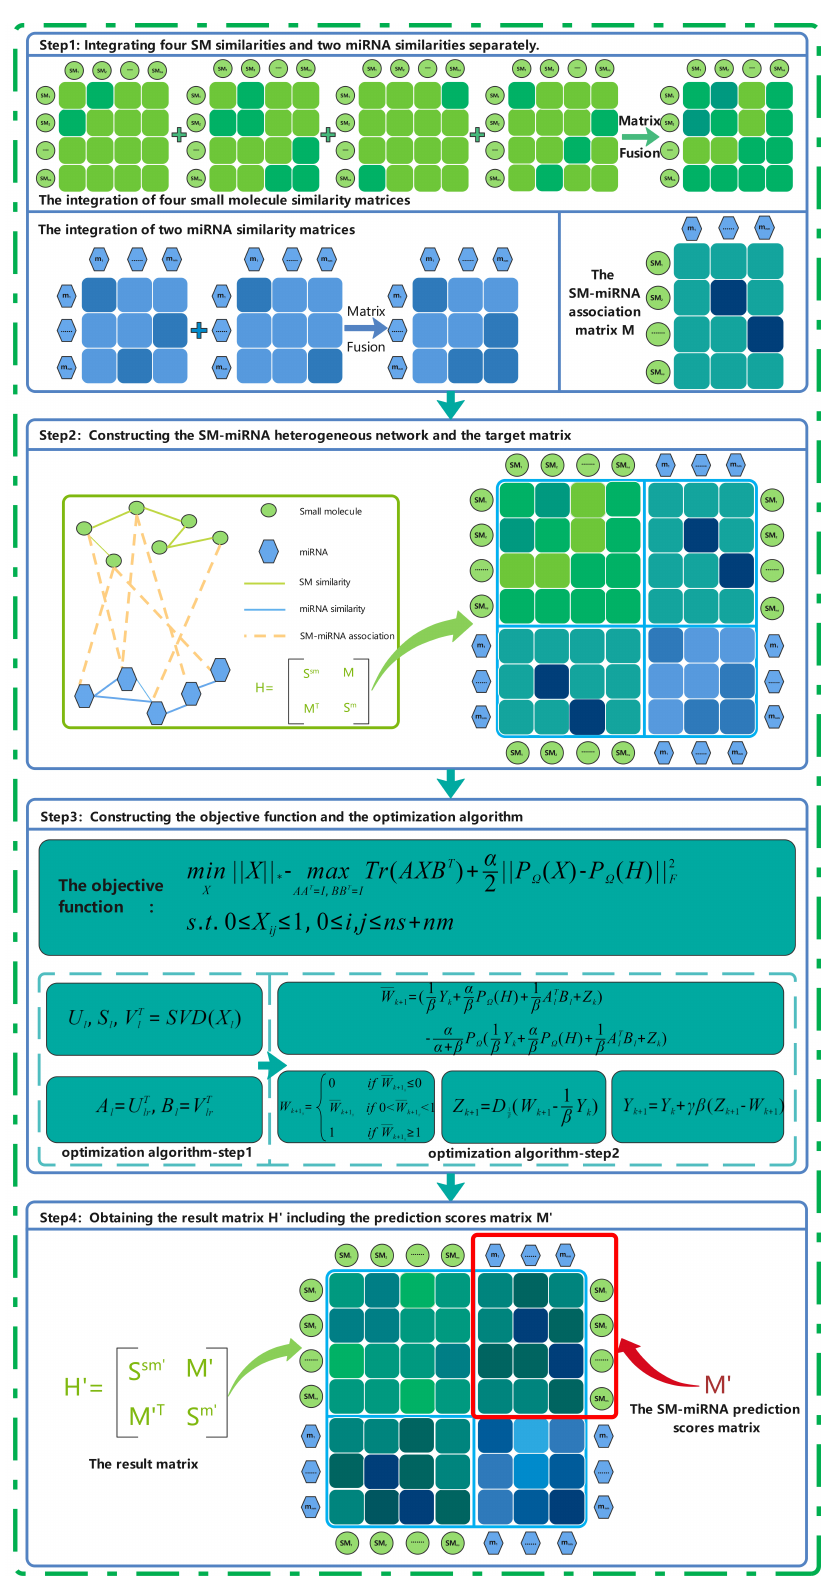
Figure 1. The framework of AMCSMMA. ( 1 ) Integrating different biological data similarities. ( 2 ) Constructing the SM–miRNA heterogeneous network and the target matrix. ( 3 ) Constructing the objective function and the optimization algorithm. ( 4 ) Obtaining the prediction score matrix through matrix